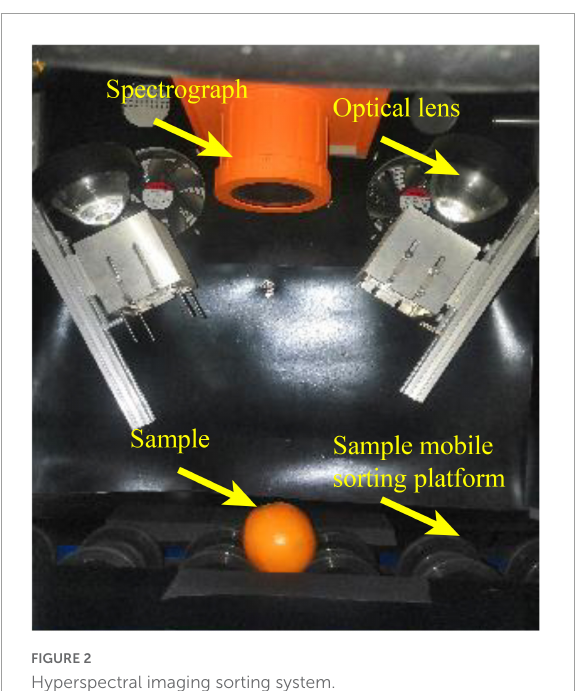
FIGURE2 Hyperspectral imaging sorting